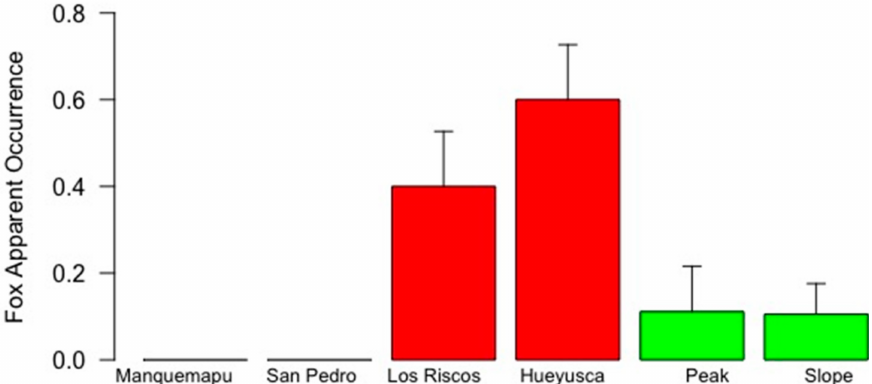
Figure 3. Fox apparent occurrence in six locations of the coastal range of southern Chile (whiskers repre- sent 1 standard error). White, red and green bars identify coast, pre-mountain range and mountain range landscapes, characterized by intermediate, high and low degrees of human intervention,